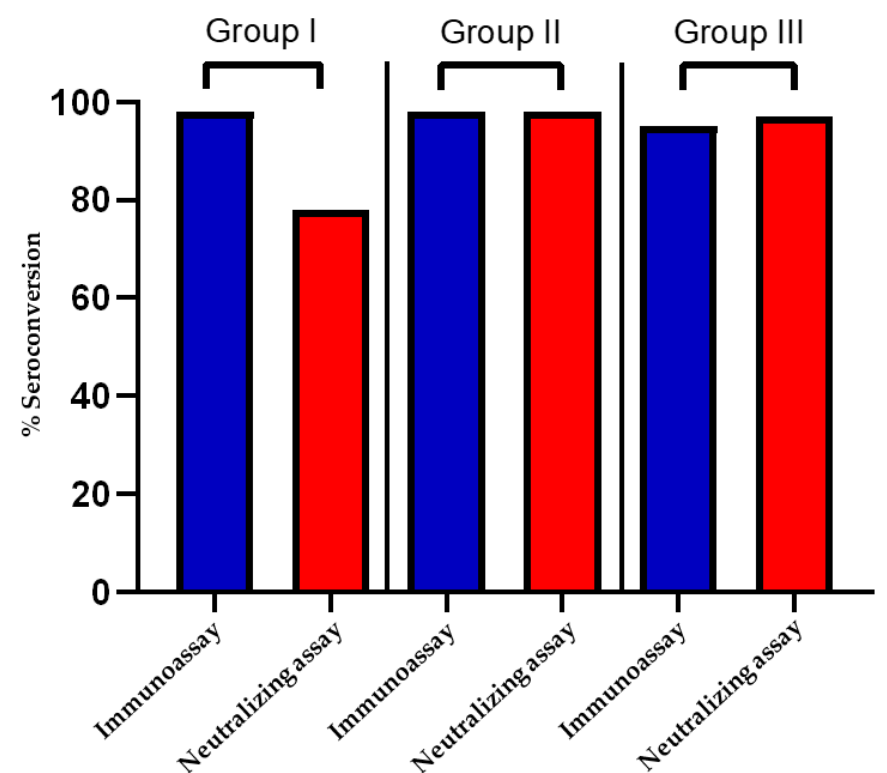
Figure 2. Seroconversion rate, using pseudotyped lentivirus antibody neutralization assay, and SARS-CoV-2 IgG II Quant immunoassay respectively, expressed as percentage of the total participants in each study group.